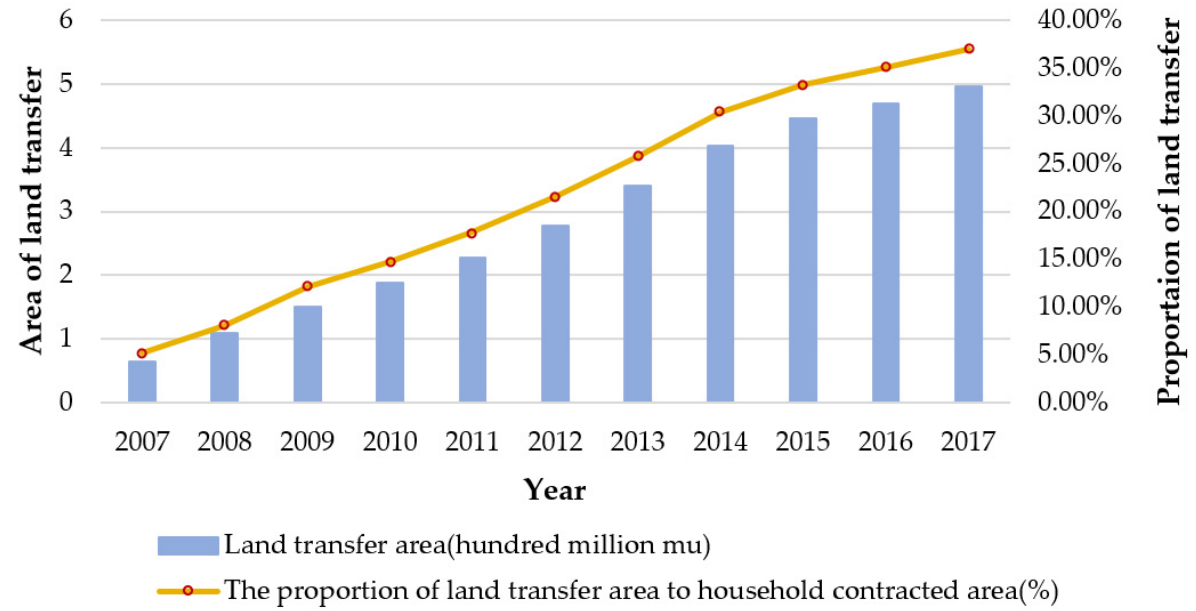
Figure 1. Land transfer in China